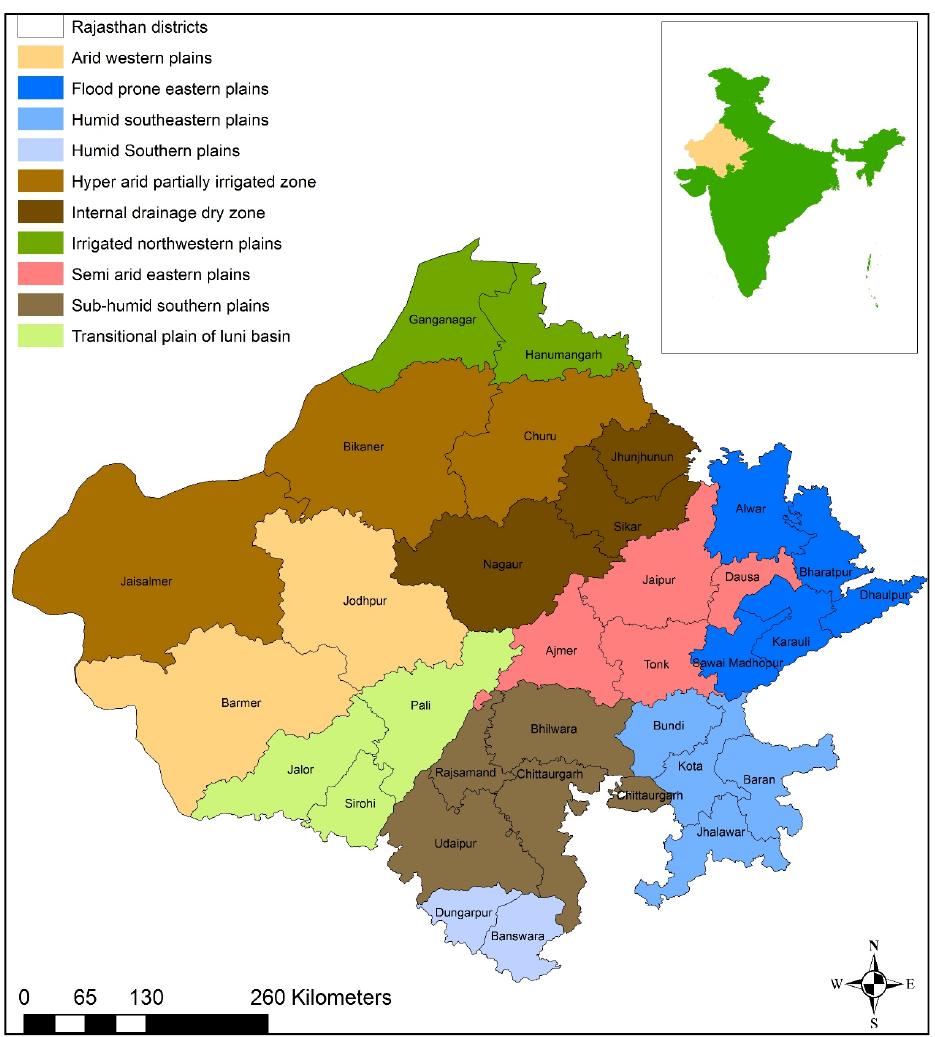
Figure 1. Rajasthan state with different agroclimatic zones. The inset shows the location of Rajasthan state in